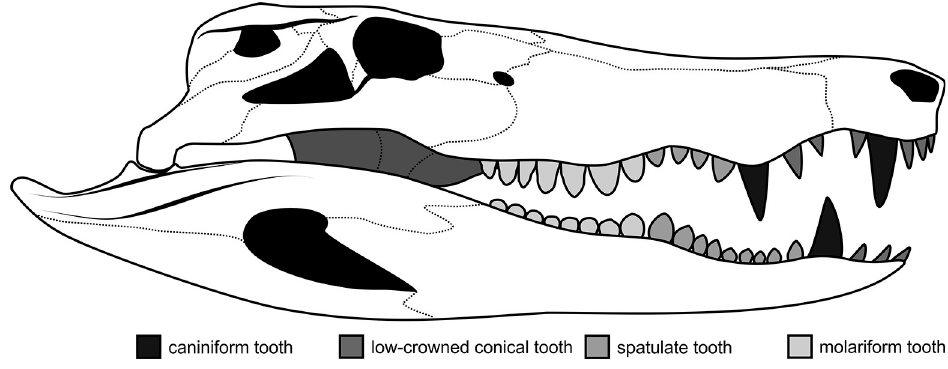
Fig 6. Scheme of a peirosaurid skull showing heterodont teeth and the probable location of morphotypes I to IV. Abbreviations: 1, caniniform tooth; 2, low-crowned conical tooth; 3, spatulate tooth; 4, molariform